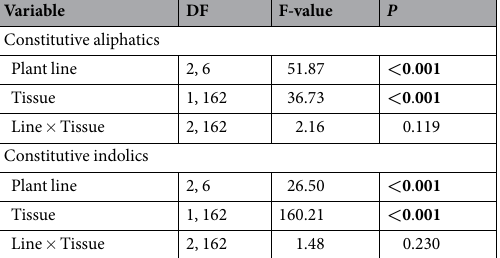
Table 3. Results from general linear mixed models testing for the effects of plant domestication (i.e., plant line), plant tissue (leaves vs. stem), and their interaction on constitutive levels of aliphatic and indolic glucosinolates in leaves and stems. We used three plant lines, the wild cabbage Brassica oleracea ssp. oleracea and two domesticated varieties of this species ( B . oleracea var. acephala and B . oleracea var. capitata). F-values, degrees of freedom (numerator, denominator), and associated significance levels ( P ) are shown. Significant effects ( P < 0.05) are in